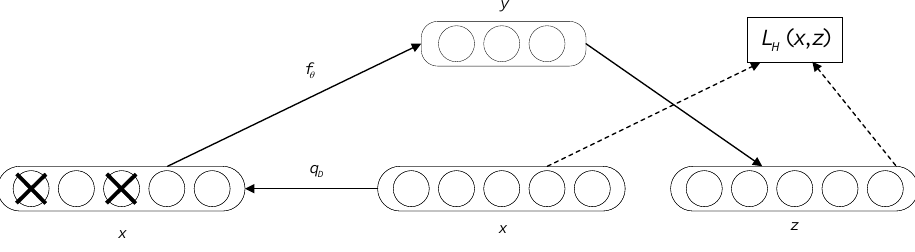
Figure 5. The structure of the denoising autoencoder.